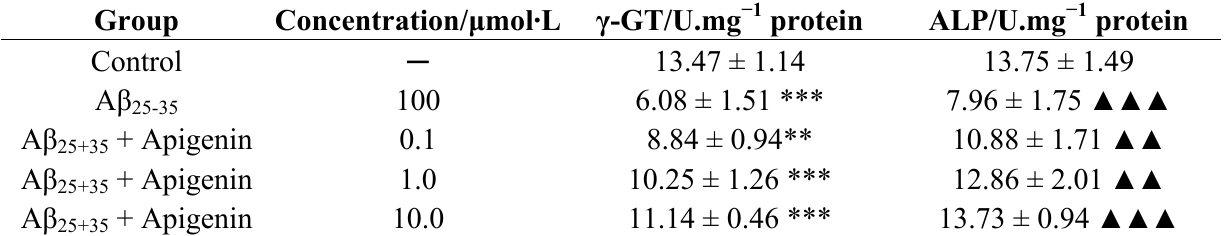
-induced toxicity. 25-35